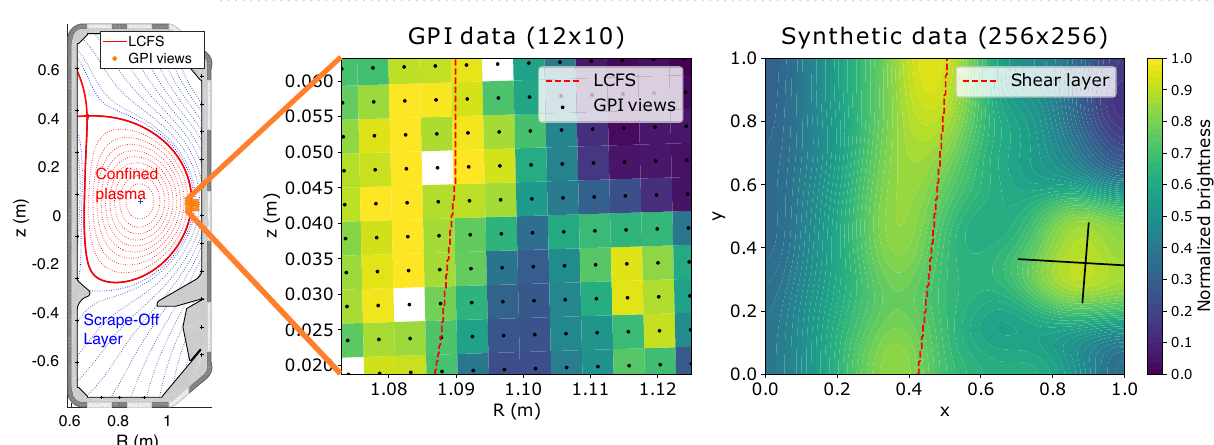
Figure 1. The schematic of the Tokamak à Configuration Variable (TCV) (left) and its interior (right). Credits: EPFL (left) and A. Herzog, EPFL (right).